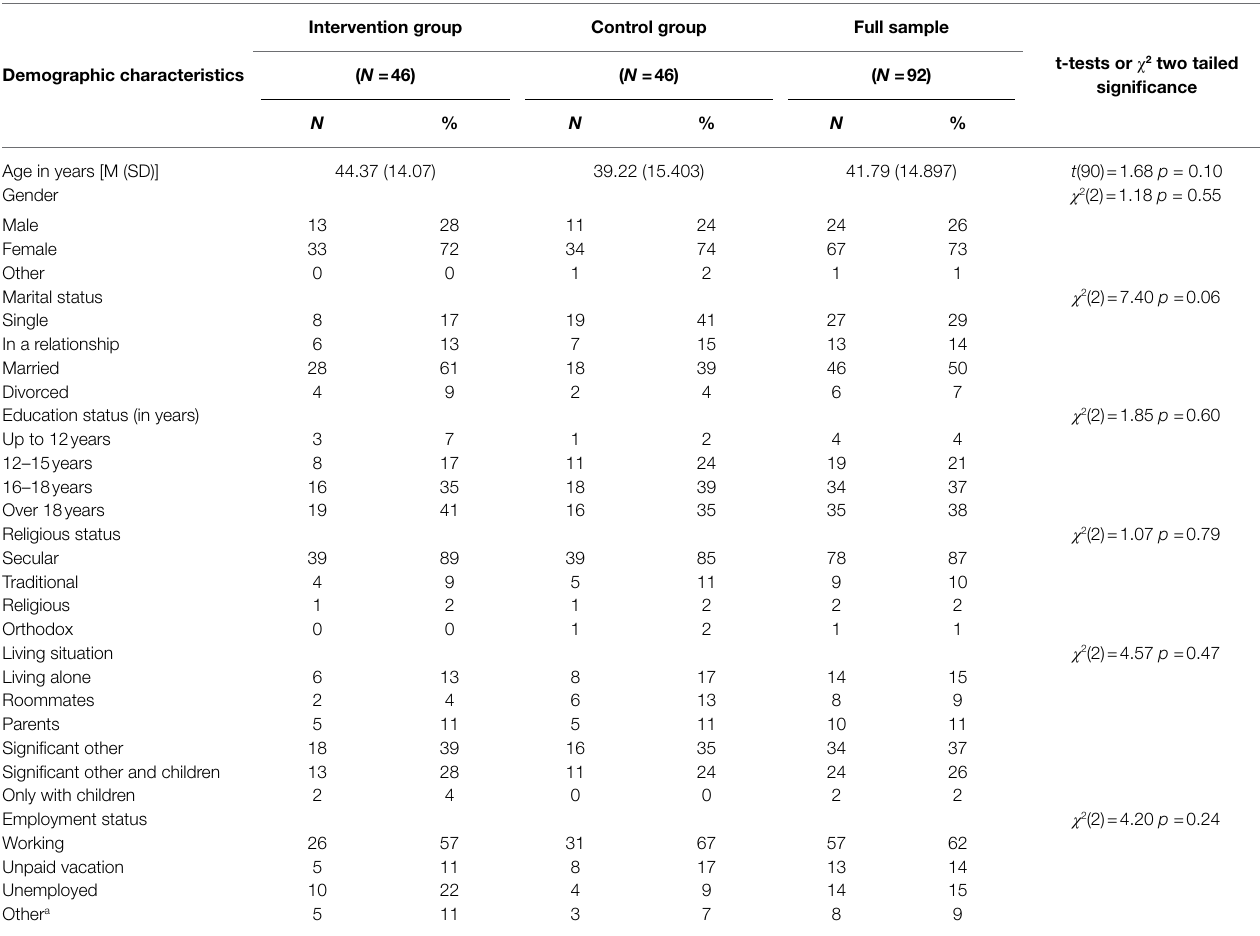
TABLE 1 | Demographic characteristics of participants pre-intervention.